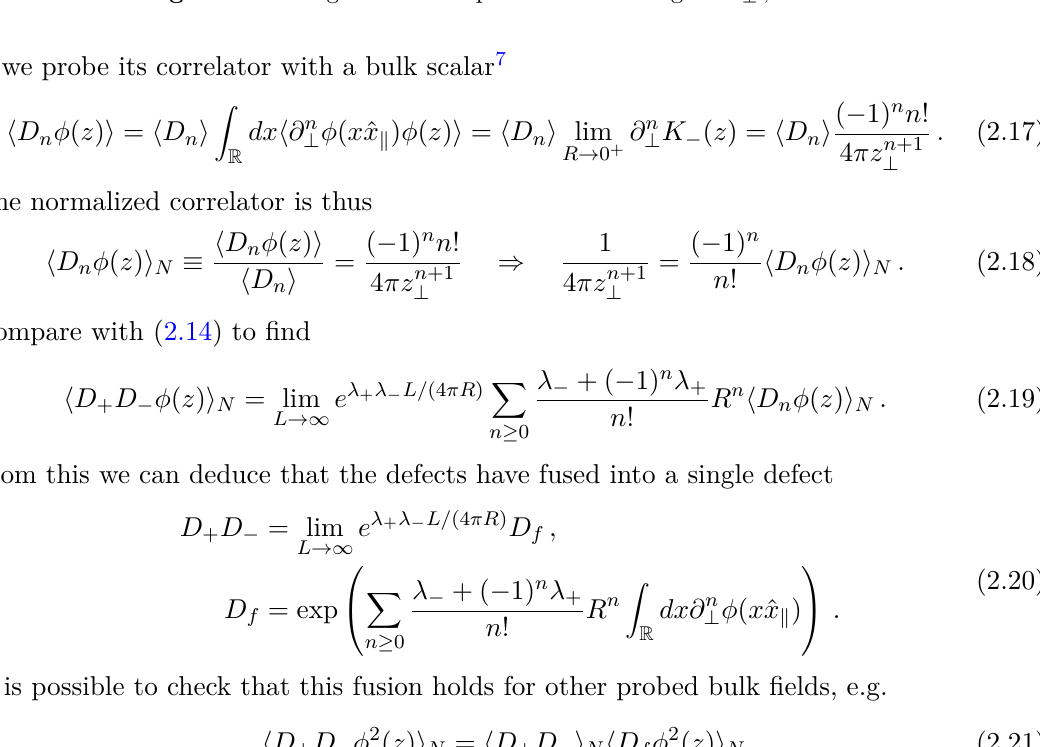
Figure 2 . A diagrammatic depiction of the integrals I ± , J and K